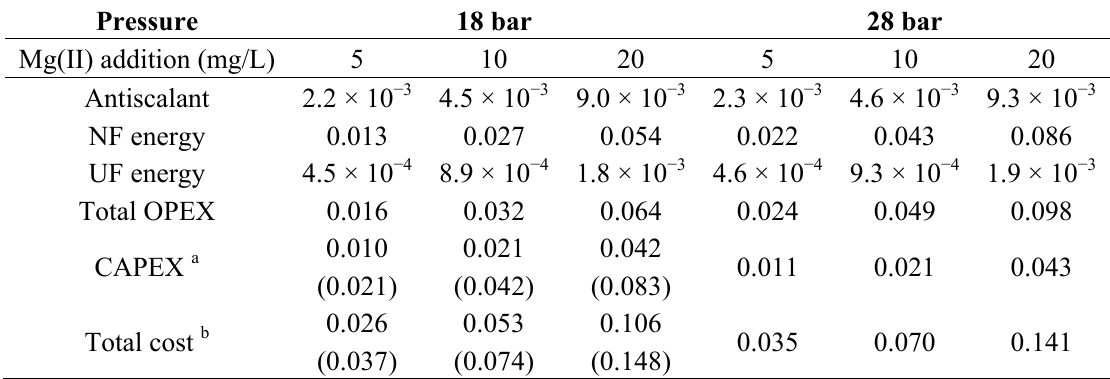
Table 2. Estimation of the operational cost components and capital costs (cents per m 3 of desalinated water) associated with the presented process, for six different case